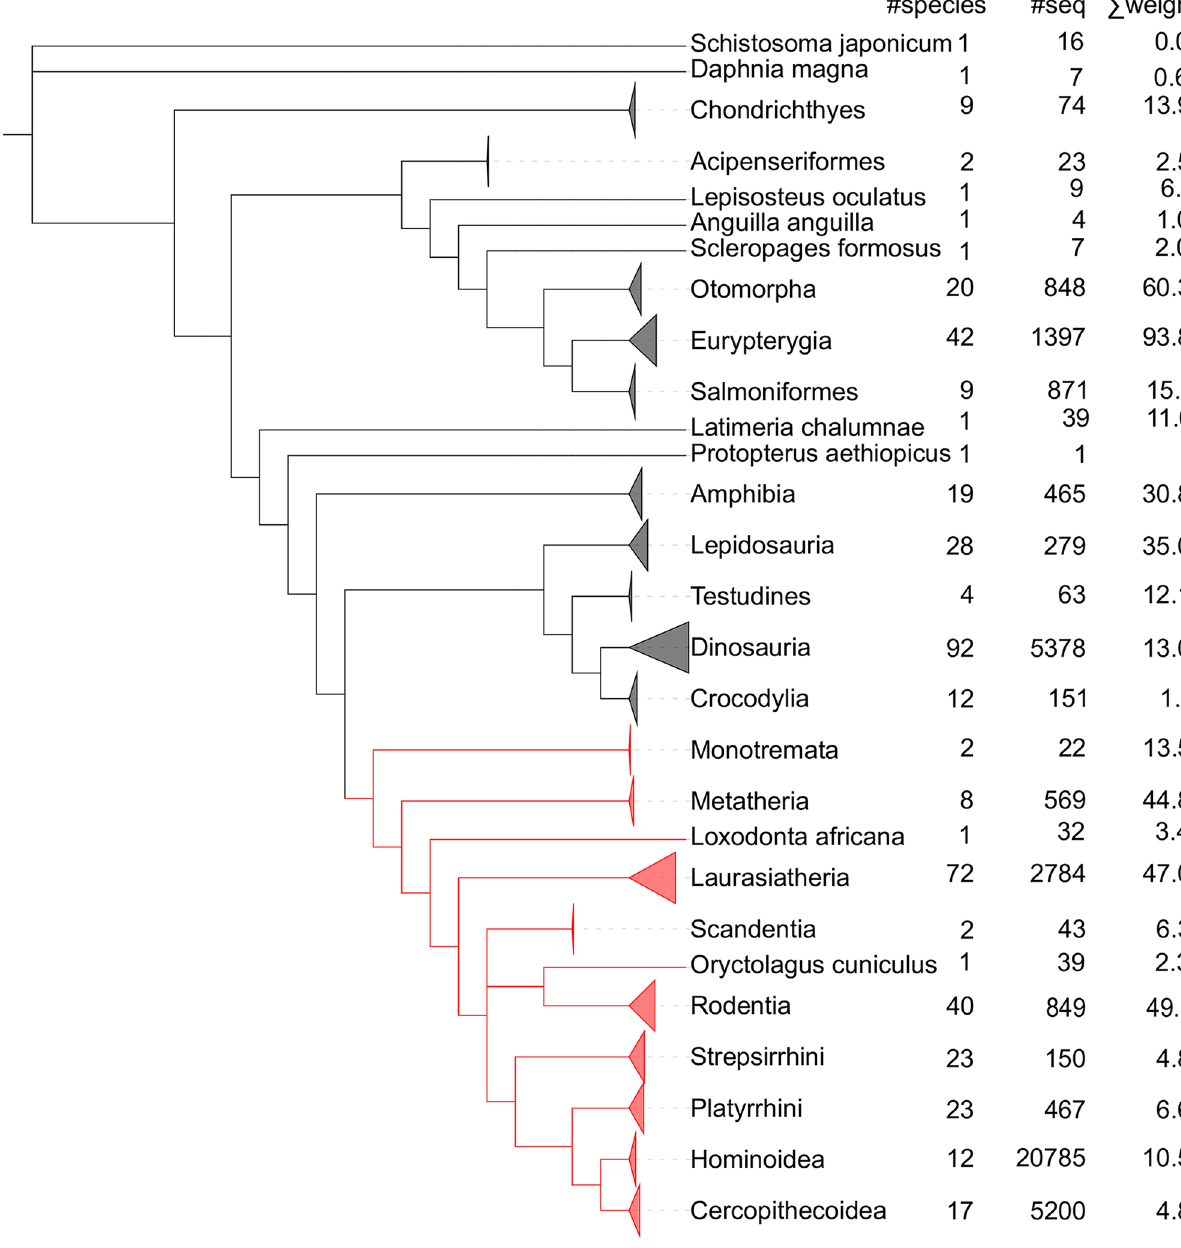
Fig 1. Species tree with number of sequences. Topological species tree issued from phyloT that illustrates the 445 vertebrate species represented in PFAM MHC-I alpha 1 and 2 domain family (PF00129). The number of sequences (column 2) and the number of species (column 1) per clade are indicated on the right. In red, we highlighted the mammalian clades. The sum of the weights in DCA of all sequences in each clade is shown in the last column.